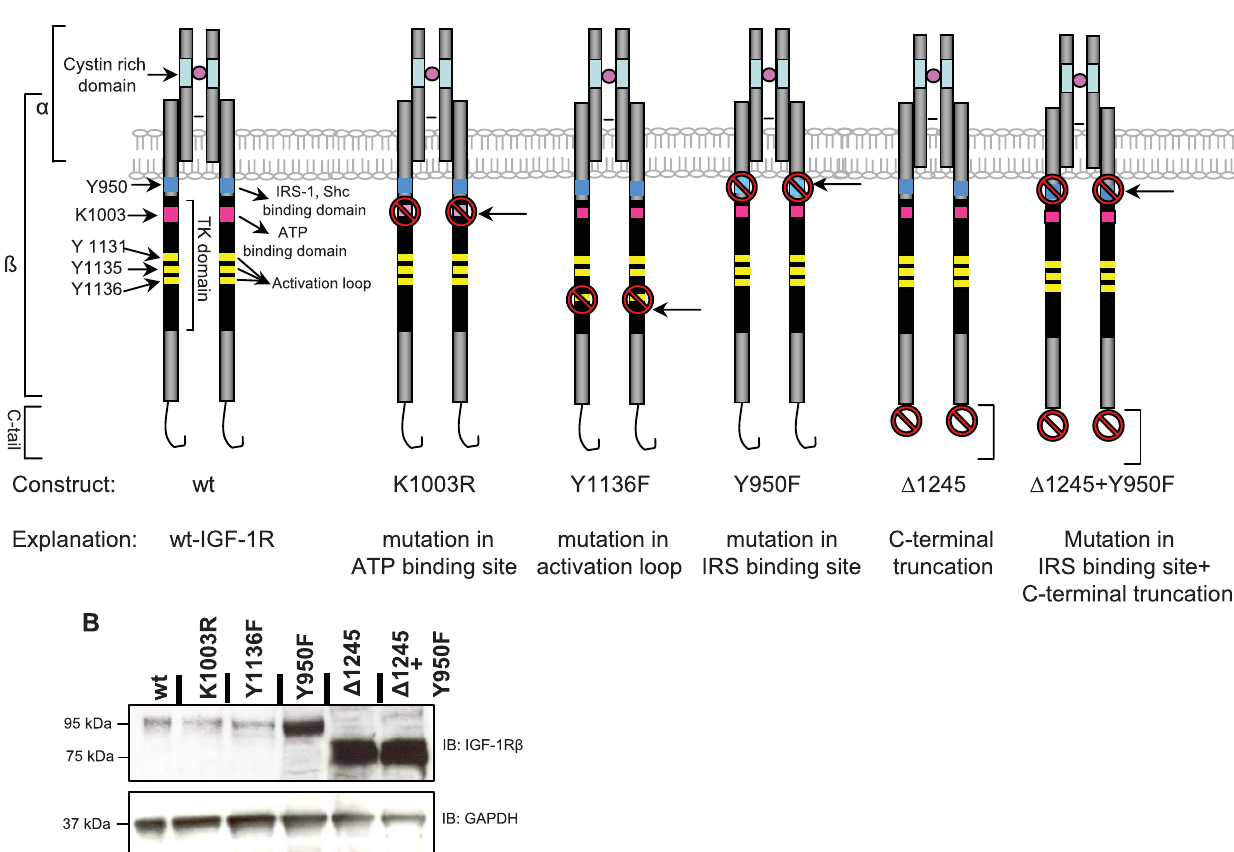
Figure 1. Wild type and mutant IGF-1R constructs. A. IGF-1R is a heterodimeric receptor with two identical ß-subunit and two identical a -subunits. The a -subunit is completely extracellular, while the ß-subunit spans the membrane. The intracellular portion (residues 931–1337) has a TK domain with intrinsic kinase activity. Important tyrosine residues in the TK domain, know as activation loop, are (Y1131, Y1135 and Y1136) shown in green. Tyrosine residue Y950 (in blue) is, when phosphorylated, a docking site for binding of signaling molecules. Other important regions of the receptor are the ATP binding site (K1003) and the C-terminal domain important for phosphorylation and signaling, respectively. B. The expression of all IGF-1R variants were investigated on cells growing under basal conditions (complete medium supplemented with serum). Cell lysates were subjected to western blotting using antibodies to IGF-1R ( b -subunit) and GAPDH (loading control).